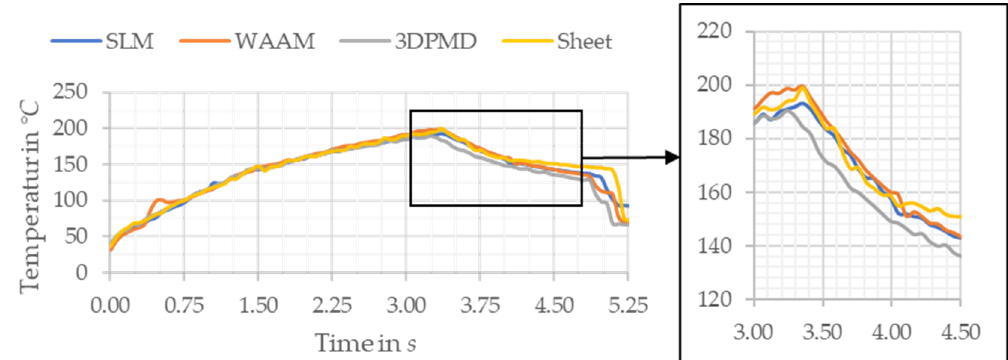
Figure 14. Averaged temperature curves during the machining process.